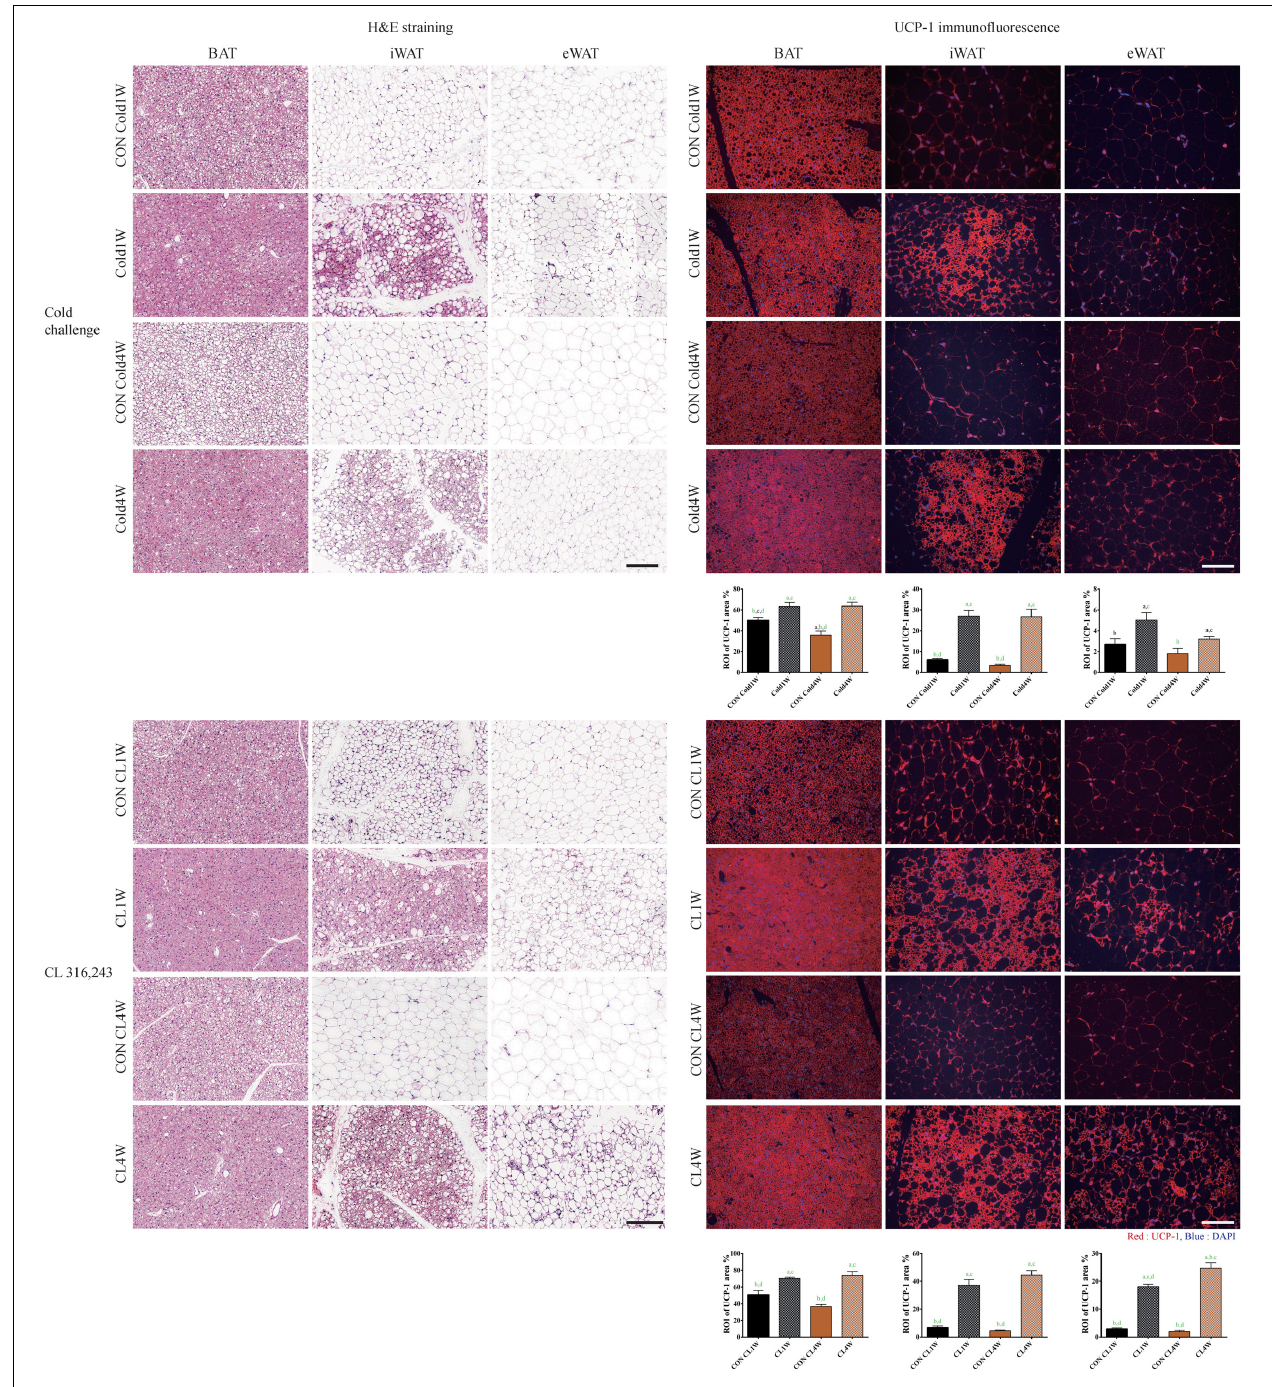
FIGURE 2 | Effects of cold challenge or CL 316,243 treatment for 1 week or 4 weeks on the morphology and UCP-1 immunofluorescence of BAT, iWAT, and eWAT. Representative images of hematoxylin and eosin staining of BAT, iWAT, and eWAT, after 1 week or 4 weeks of cold challenge or CL 316,243 treatment. Hematoxylin and eosin staining show that lipid accumulation is decreased in BAT of the Cold1W, Cold4W, CL1W, and CL4W groups when compared with that in their control groups. In addition, UCP-1 immunoreactive structures are prominently found in BAT and iWAT of the Cold1W, Cold4W, CL1W, and CL4W groups when compared with those in the CON Cold1W, CON Cold4W, CON CL1W, and CON CL4W groups, respectively. Scale bar = 100 µ m. Region of interest (ROI) is the region of interest of UCP-1 immunofluorescent structures in fat tissues is also shown. ‘a’ indicates a significant difference when compared with the CON Cold1W group ( p < 0.05); ‘b’ indicates a significant difference when compared with the Cold1W group ( p < 0.05); ‘c’ indicates a significant difference when compared with the CON Cold4W group ( p < 0.05); ‘d’ indicates a significant difference when compared with the Cold4W ( p < 0.05) group; and green ‘a’,’b’,’c’, and ‘d’ indicates a significant difference ( p < 0.01). Data are shown as mean +